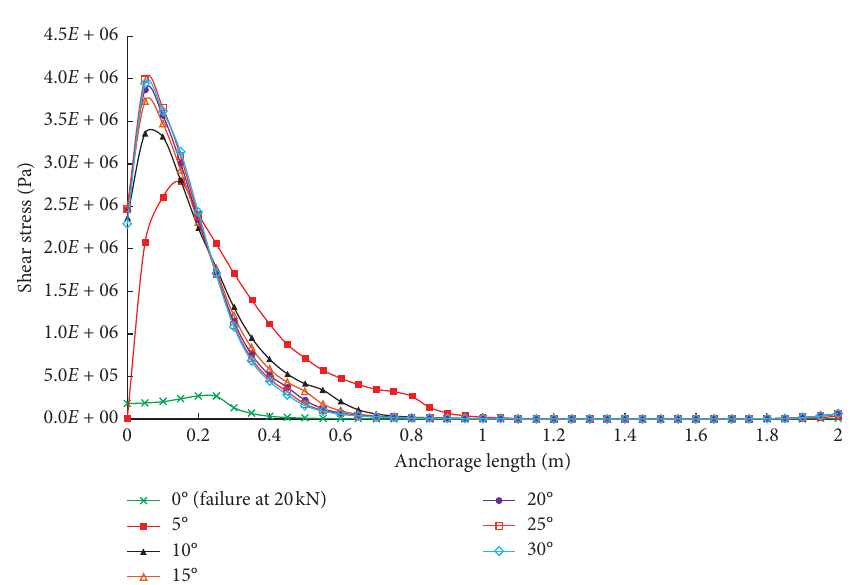
Figure 14: Distributions of the interface shear stress under different dilatancy angles for a rockbolt load of 200kN.